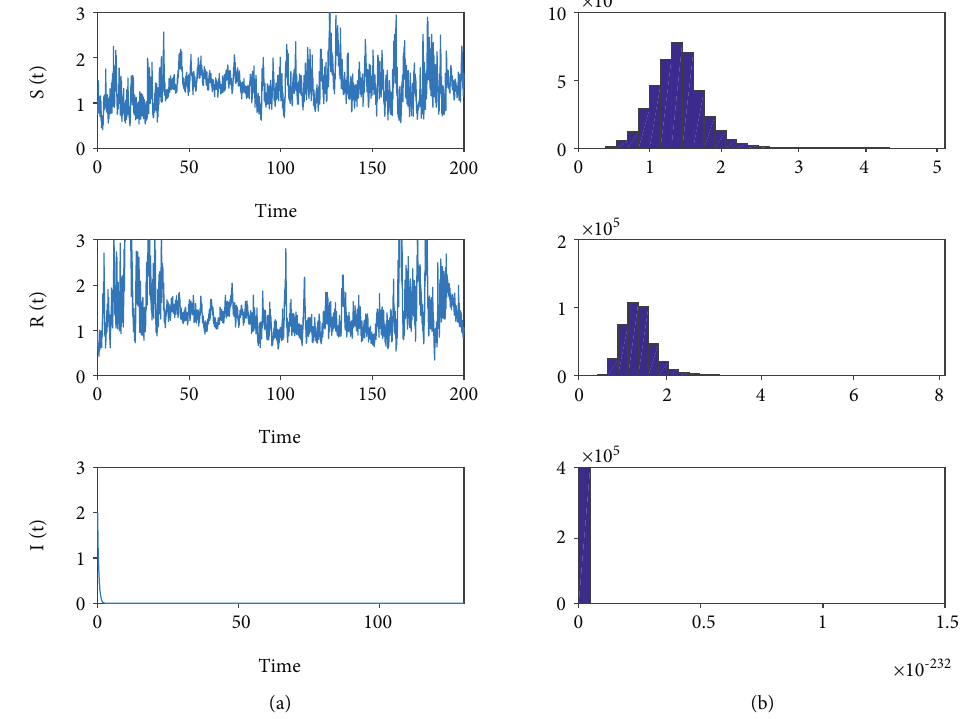
Figure 2: The left column re fl ects the simulation of number variations of S ð t Þ , R ð t Þ and I ð t Þ in model (26) with the initial value S ð 0 Þ = 0 : 8, R ð 0 Þ = 1 : 1 , and I ð 0 Þ = 0 : 7 and the noise intensities given in Example 2. The right column reveals the relevant histogram of density functions of the classes S ð t Þ , R ð t Þ , and I ð t Þ . Step size Δ t = 0 : 001